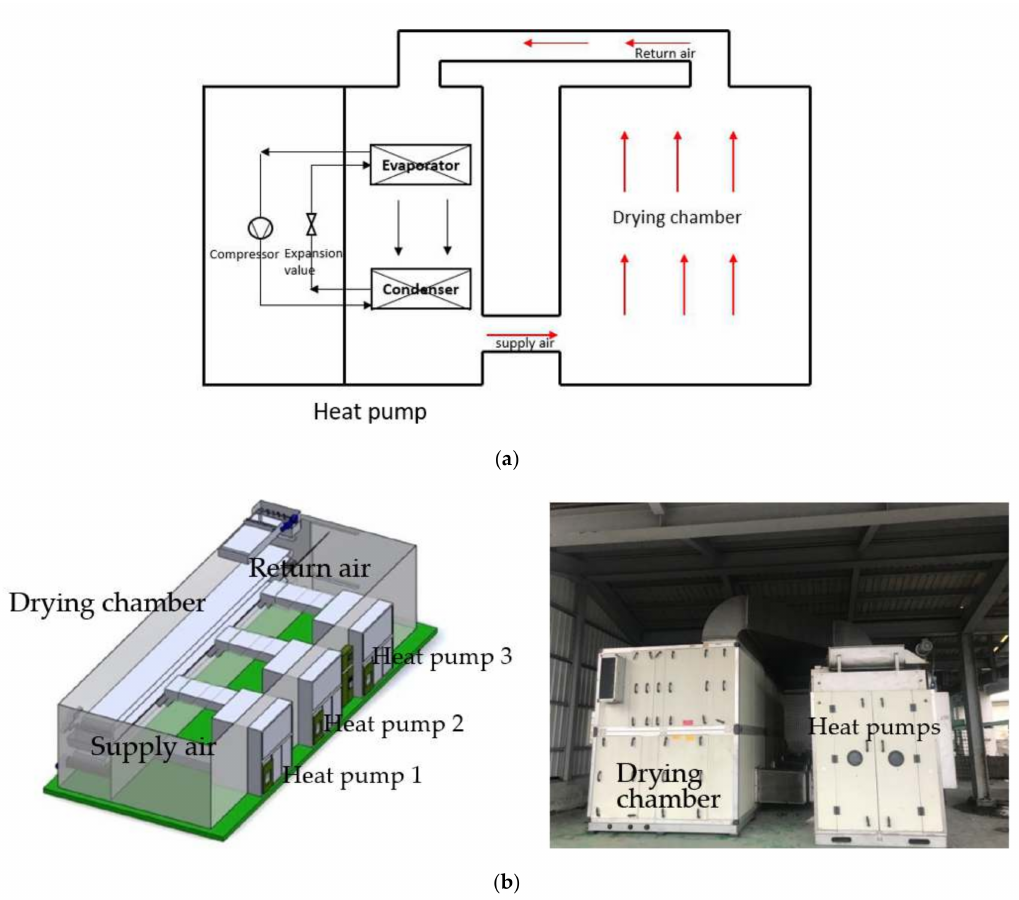
Figure 1. Schematic diagram of the sludge continuous feeding heat pump drying system used in this study. ( a ) Schematic diagram of a drying system with a heat pump. ( b ) Schematic diagram of a continuous sludge feeding drying system with three heat pump